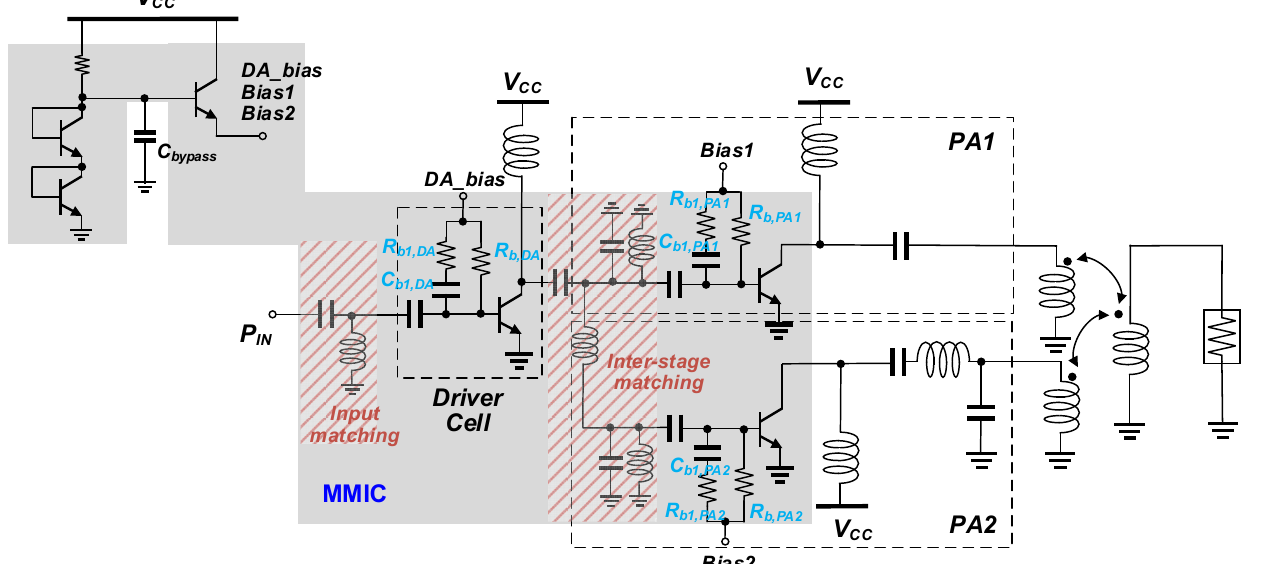
Figure 7. Schematic of the proposed HBT PA with a parallel power-combining transformer.